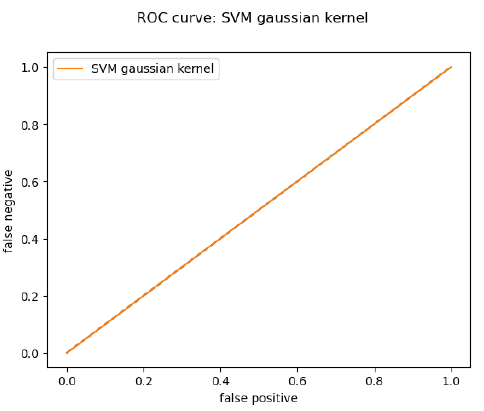
Figure 12. Online Gaussian kernel ROC